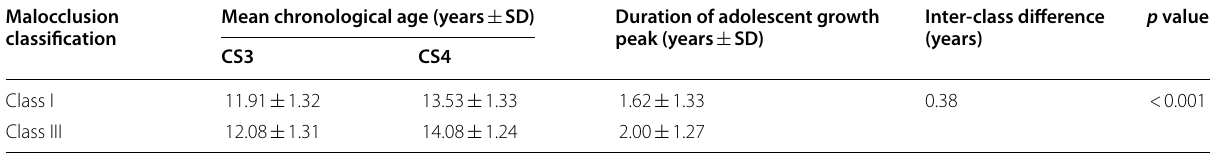
Table 2 Comparison of the mean duration of adolescent growth peak between two skeletal classes (independent samples t test) Malocclusion